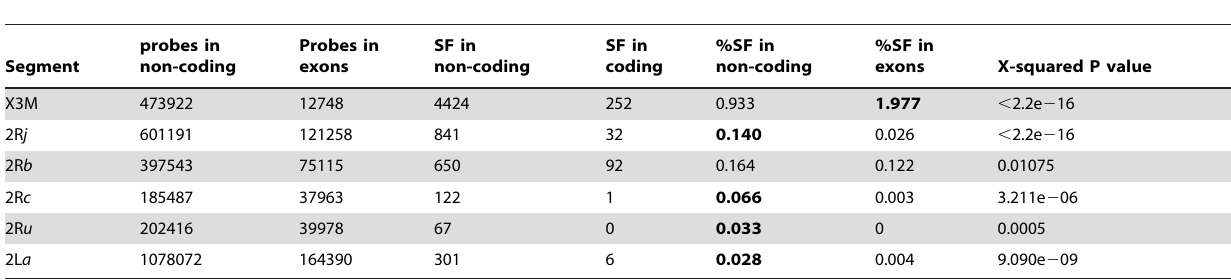
Table 3. Divergence in coding sequences contained in chromosome inversions.